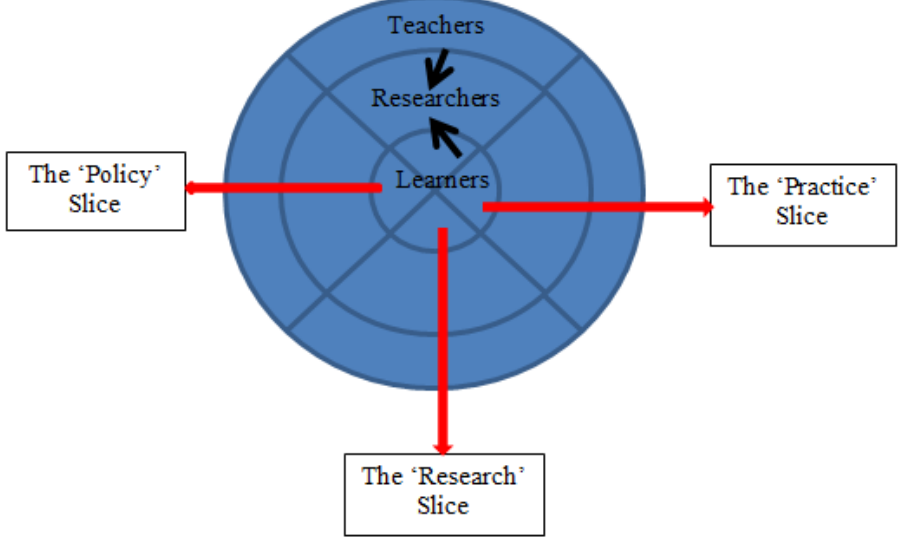
Figure 2 . The approach taken by the researchers in this special